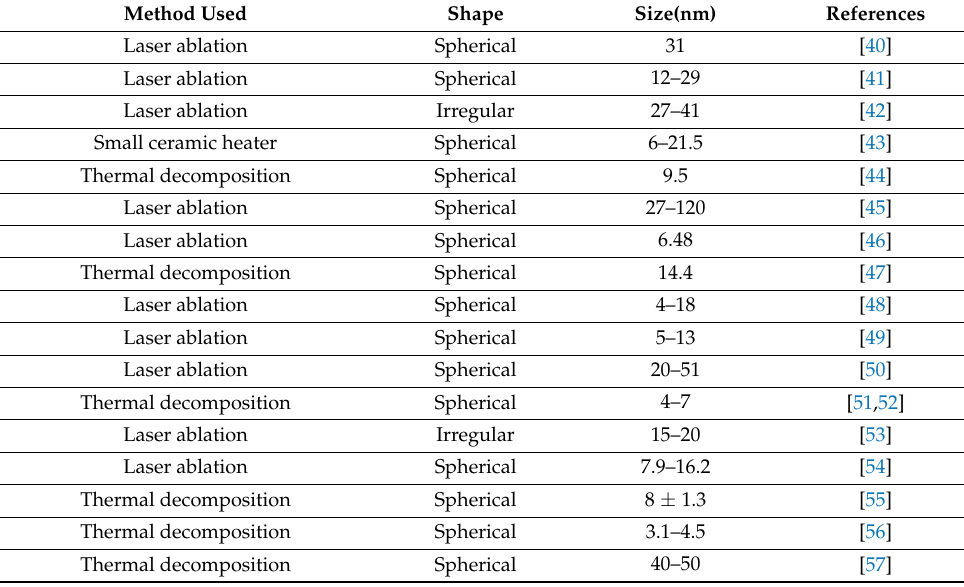
Table 4. List of various physical methods used for the synthesis of Ag